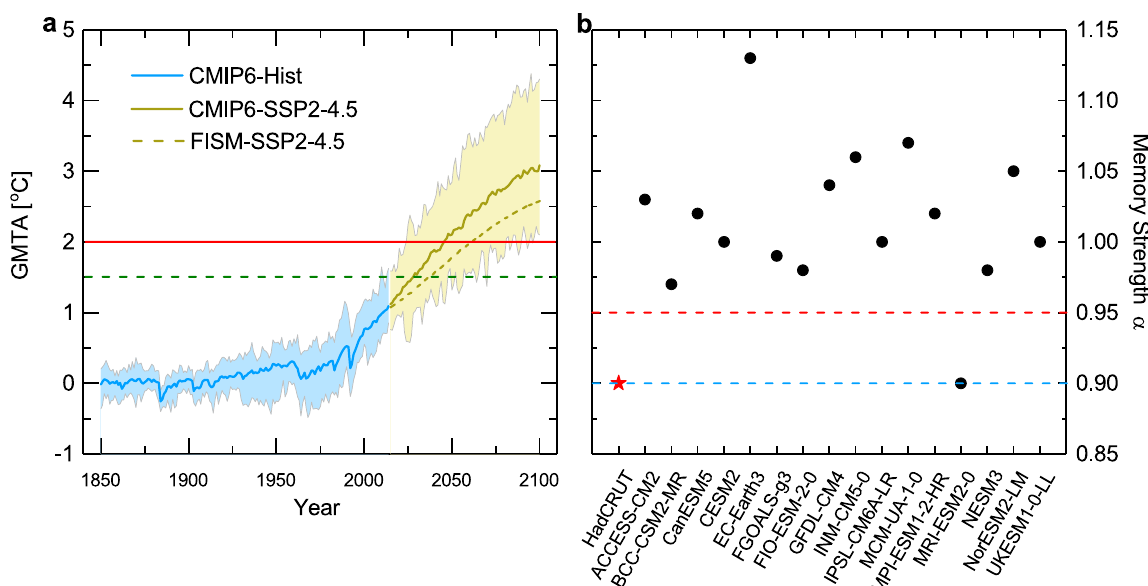
Fig. 4 Comparison of the GMTA projections by CMIP6 models and those by the FISM-based response model. In sub- fi gure ( a ), the thicker blue and yellow curves are respectively the multi-model-mean (16 CMIP6 models) historical GMTA simulation and future projection under the SSP2-4.5 scenario. The blue and yellow areas represent the uncertainties among the 16 CMIP6 models. The yellow dashed line shows the mean projection by the FISM-based response model (see also in Fig. 3). The projected GMTA warming trend is faster in the CMIP6 models, which may be associated with the too large long-term climate memory strength. As shown in ( b ), the simulated GMTAs from 15 (out of 16) models have shown signi fi cantly stronger memory strength with larger DFA exponent α . The red dashed line indicates the 95% upper bound of the uncertainty of the α value obtained from the HadCRTU data (based on Monte-Carlo